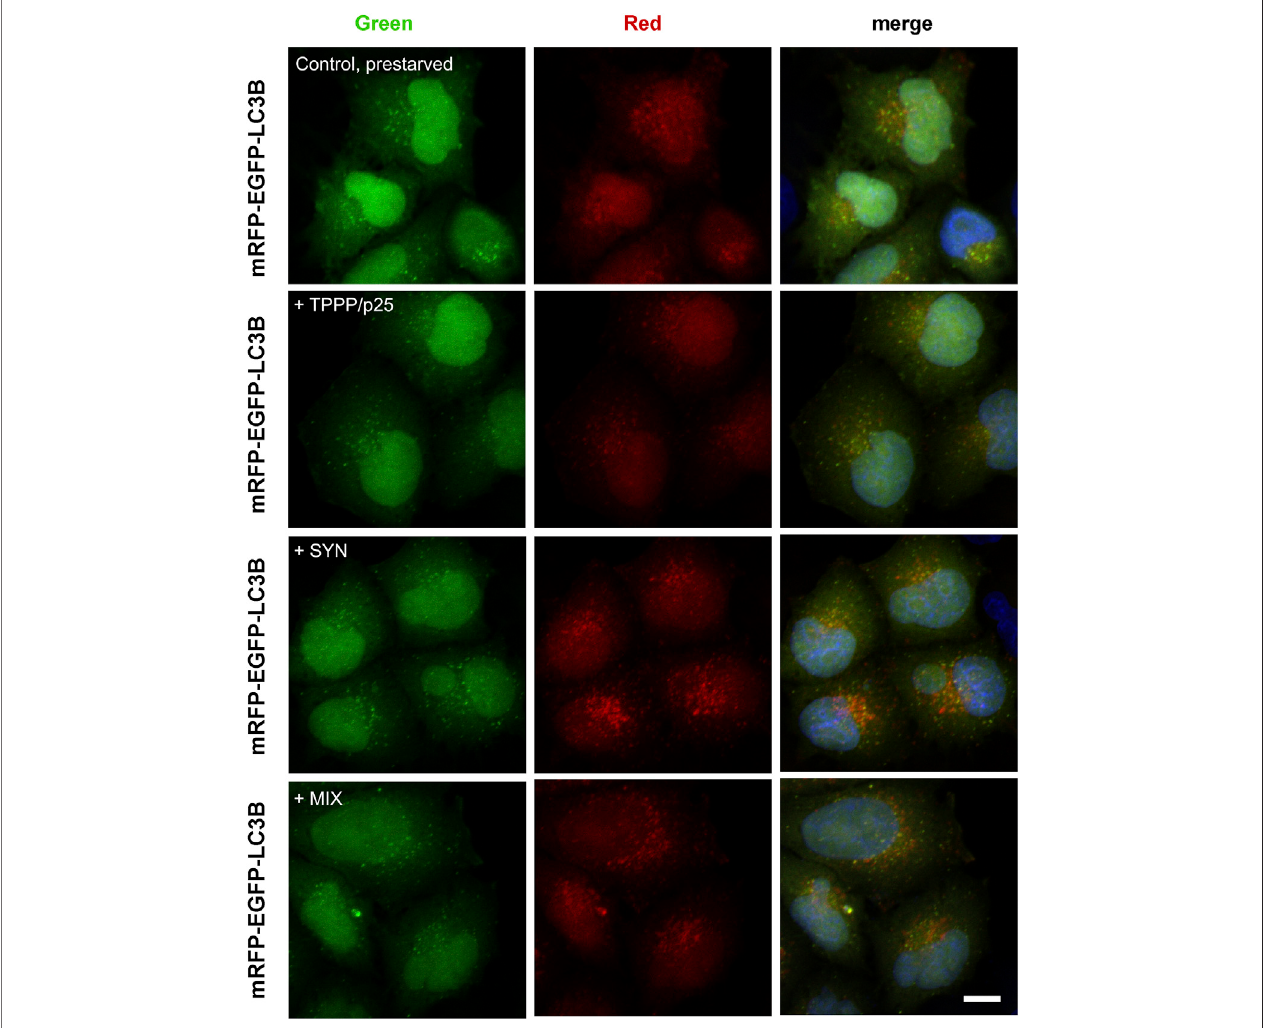
FIGURE 5 | Effects of SYN and/or TPPP/p25 on the autophagy maturation in LC3B-HeLa cells expressing tandem fl uorescent-tagged LC3B (mRFP-EGFP) as detected by fl uorescence confocal microscopy. Pre-starved cells took up TPPP/p25 (80 nM), SYN (800 nM) or their mixture (MIX, 80 nM TPPP/p25 and 800 nM SYN) from themedium.Fluorescently labeledLC3B puncta serve asan indicatorof theformationof autophagosomes (yellow) aswellas theautolysosomes (red). Nuclei were counterstained with DAPI (blue). Scale bar: 2.5 μ m.